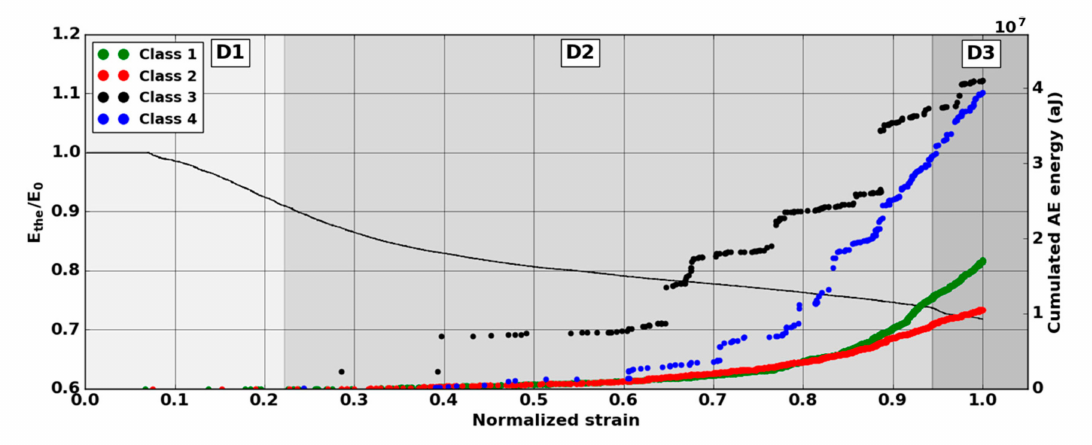
Figure 21. Kinetics of the several classes versus normalized strain during macroscopic tensile test in the fiber orientation. Results of the classification with an unsupervised classification based on fused